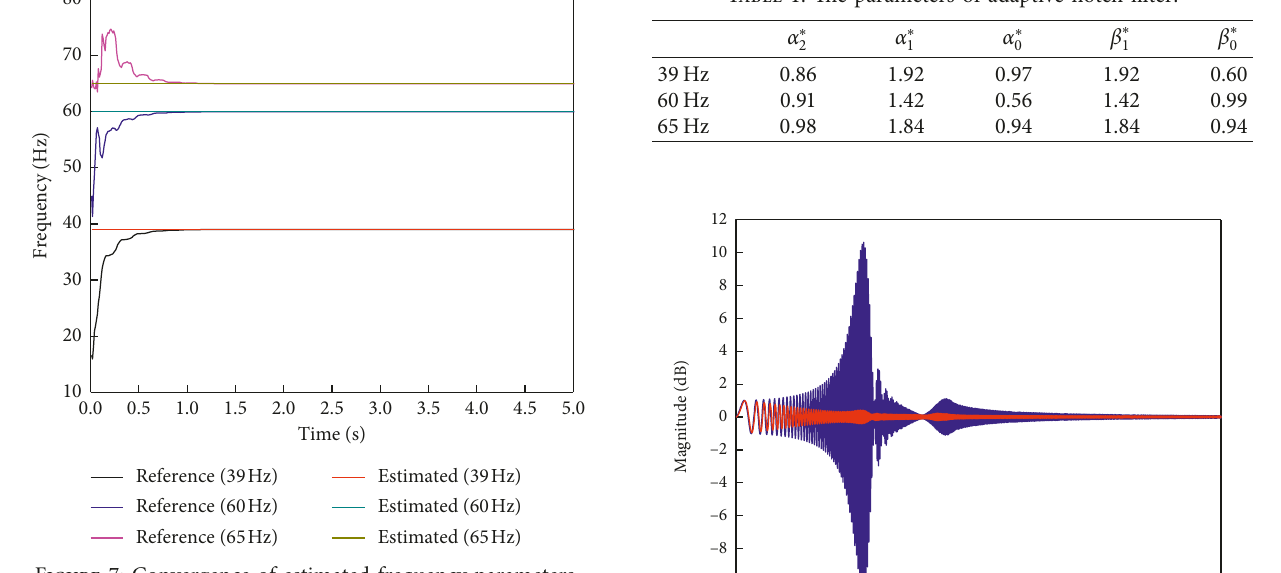
Figure 7: Convergence of estimated frequency